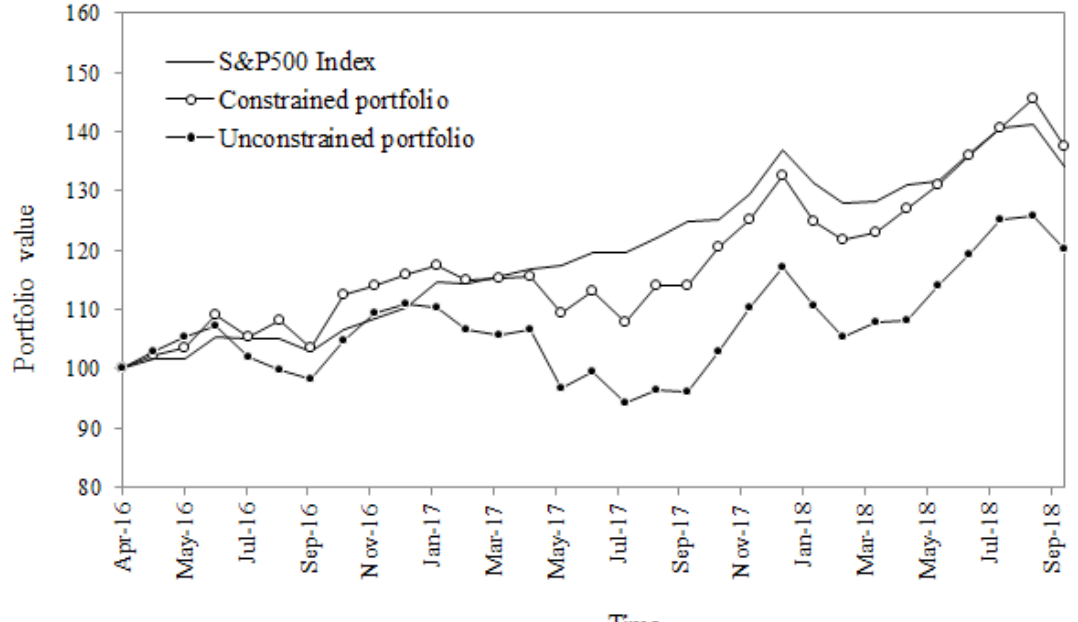
Figure 2. Cumulative monthly portfolio values, obtained by the constrained EIT portfolio ω  and by the unconstrained EIT portfolio , ω ∗ considering an out-of-sample